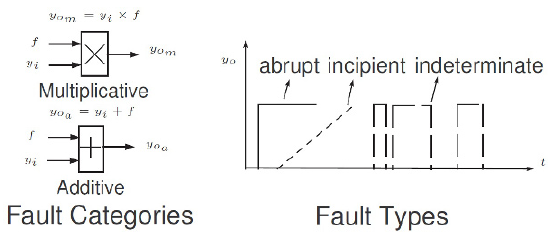
Figure 6. Sensor fault categories and